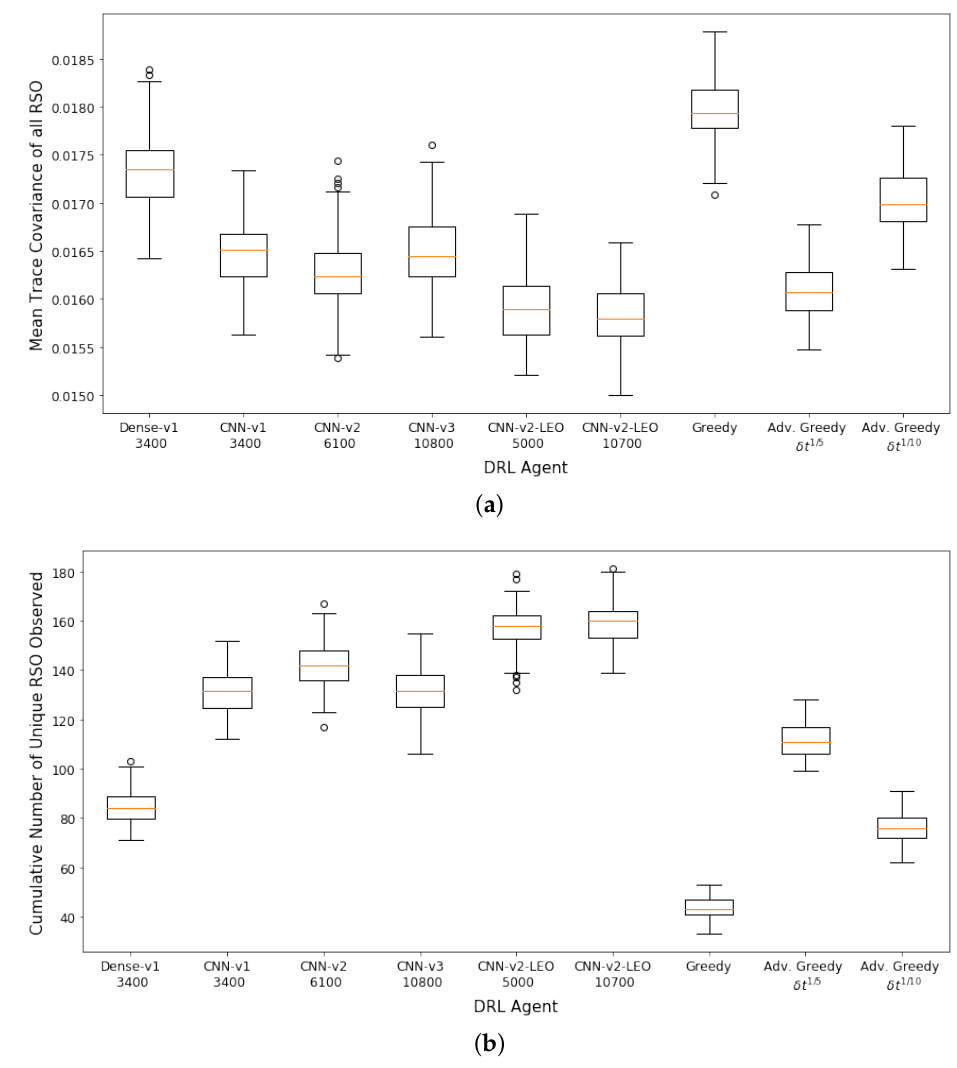
Figure 10. Aggregate performance of the DRL agents with 400 randomly initialized LEO RSOs, evaluated over 100 seeded rollouts of 90 min each. ( a ) Distribution of the final mean trace covariance at the end of the observation window (lower is better); ( b ) Distribution of the cumulative number of unique RSOs observed at the end of the observation window (higher is better). Note: CNN-v1 3400 represents a CNN-v1 DRL agent trained for 3400 training